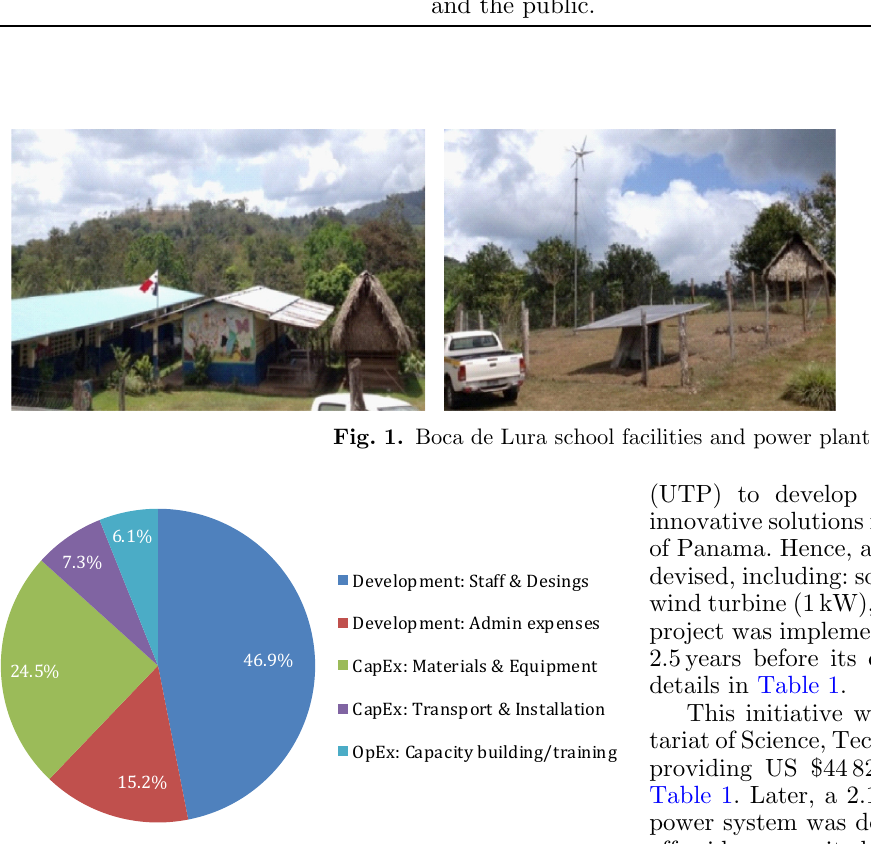
Fig. 2. Boca de Lura project costs